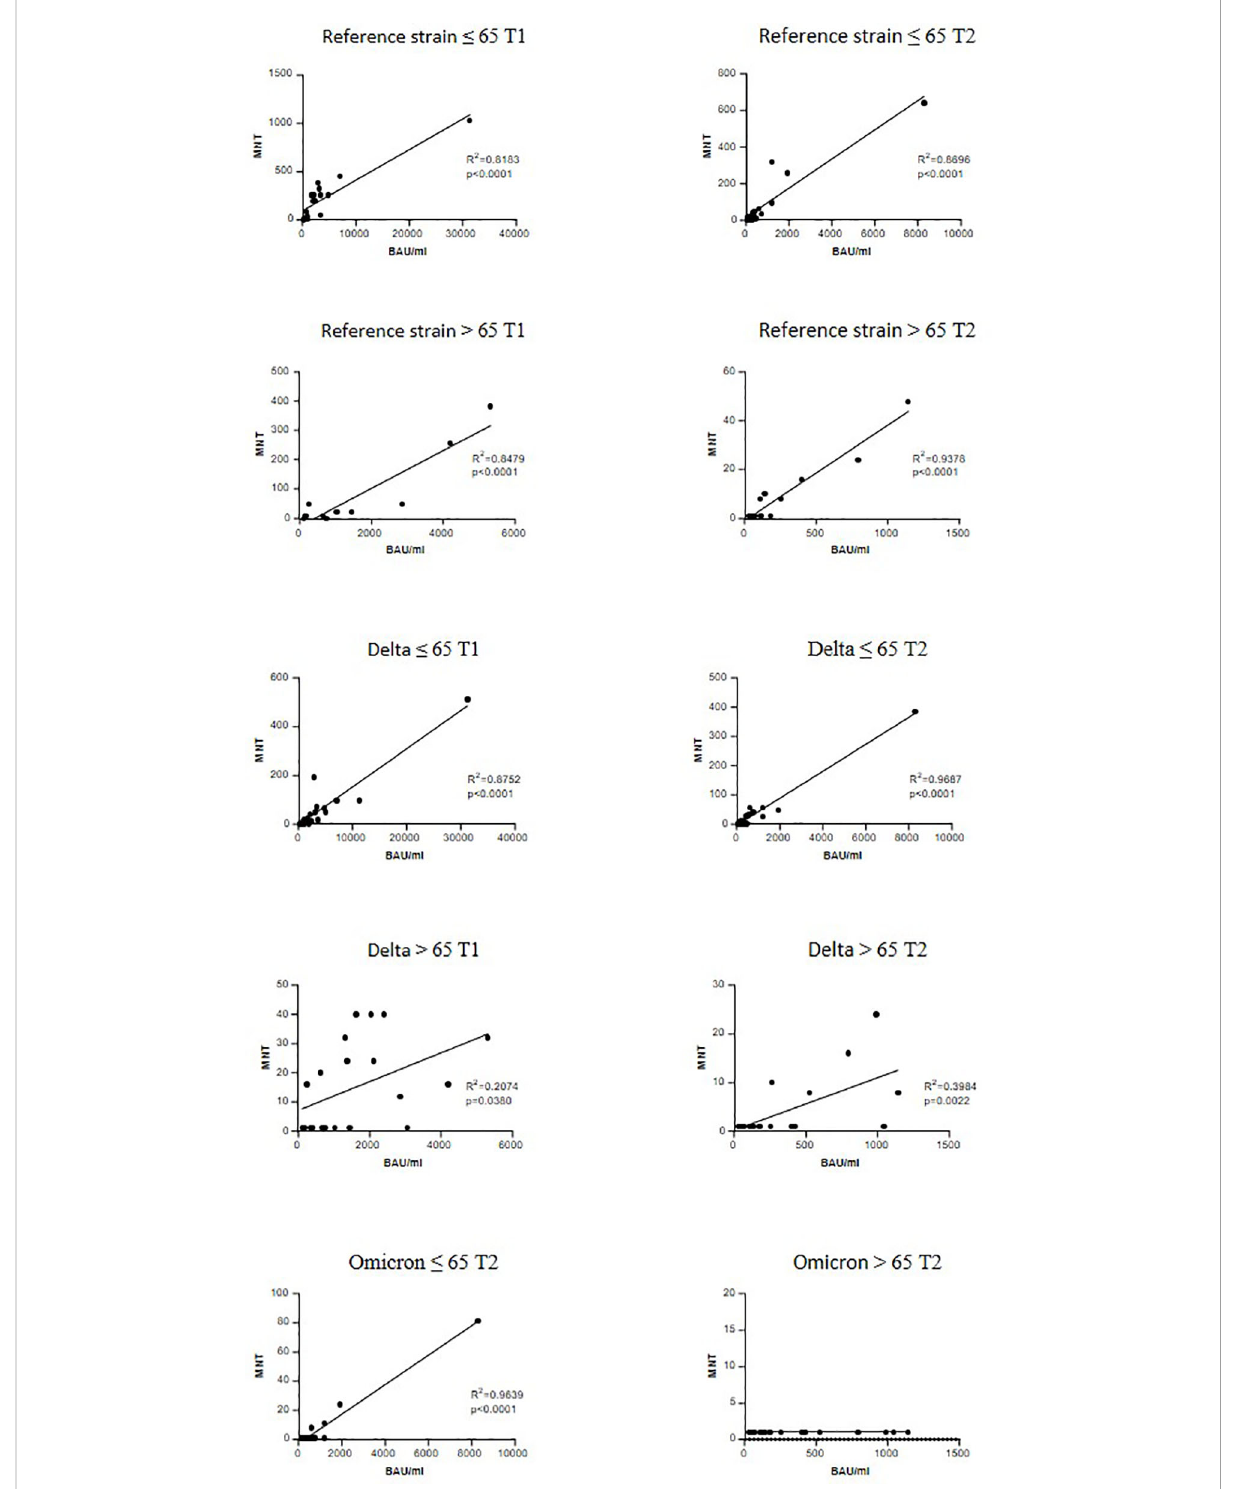
FIGURE 4 Correlation between anti-trimeric Spike IgG titers and serum neutralization activity. Linear regression correlating the levels of anti-trimeric S IgG with MNT values against reference SARS-CoV-2 strain (B), a Delta strain (AY.4) and an Omicron (BA.1). r and P values are